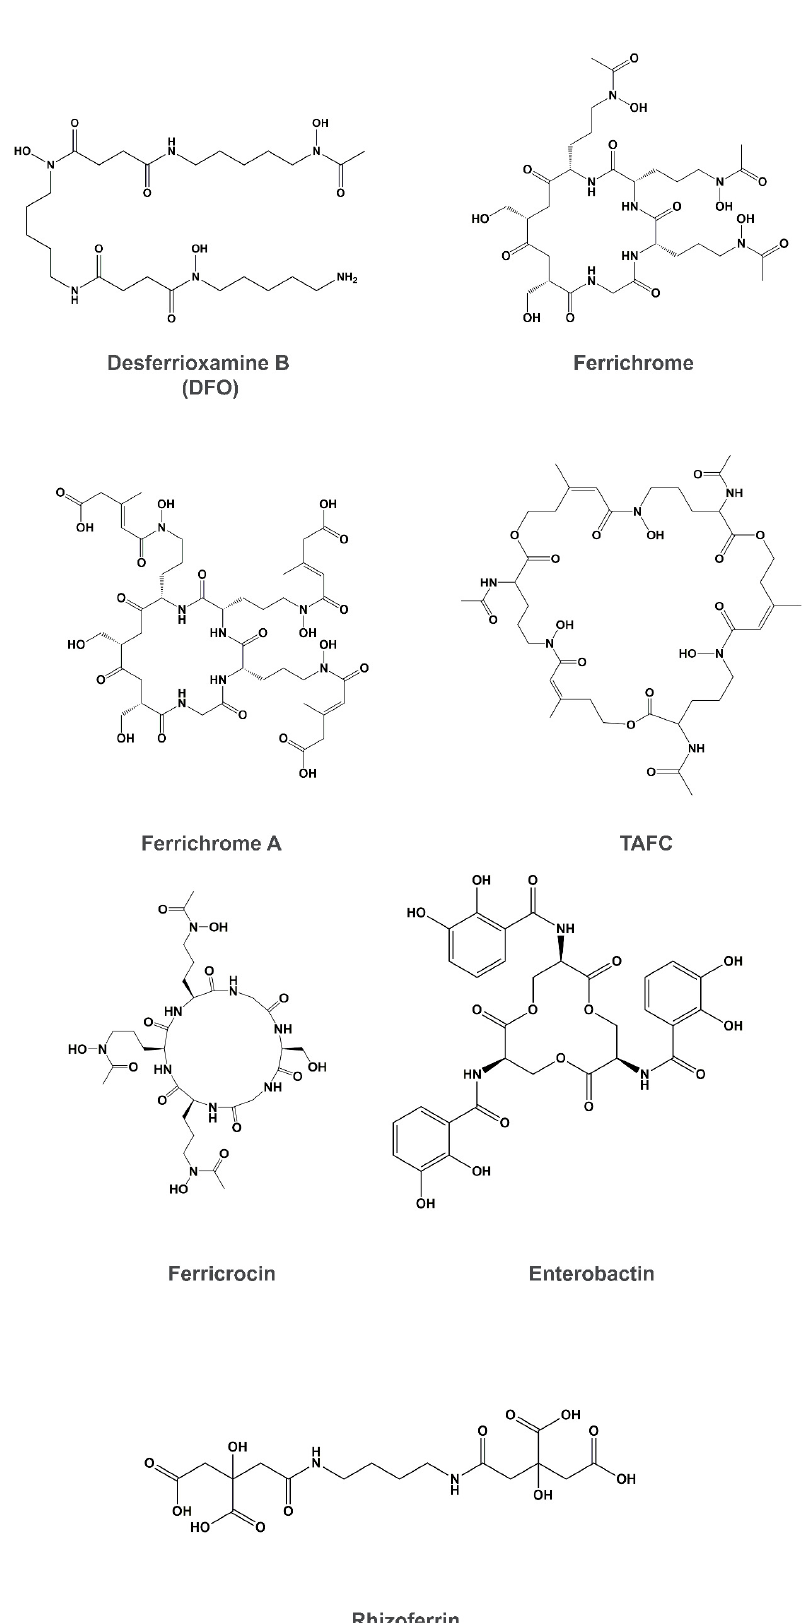
Figure 2. Representative structures of the different classes of siderophores: the Hydroxamate class — desferrioxamine B, ferrichrome, ferrichrome A and TAFC; the Catecholate class—enterobactin; and the Carboxylate—rhizoferrin. All structures are illustrated in their iron-free forms.